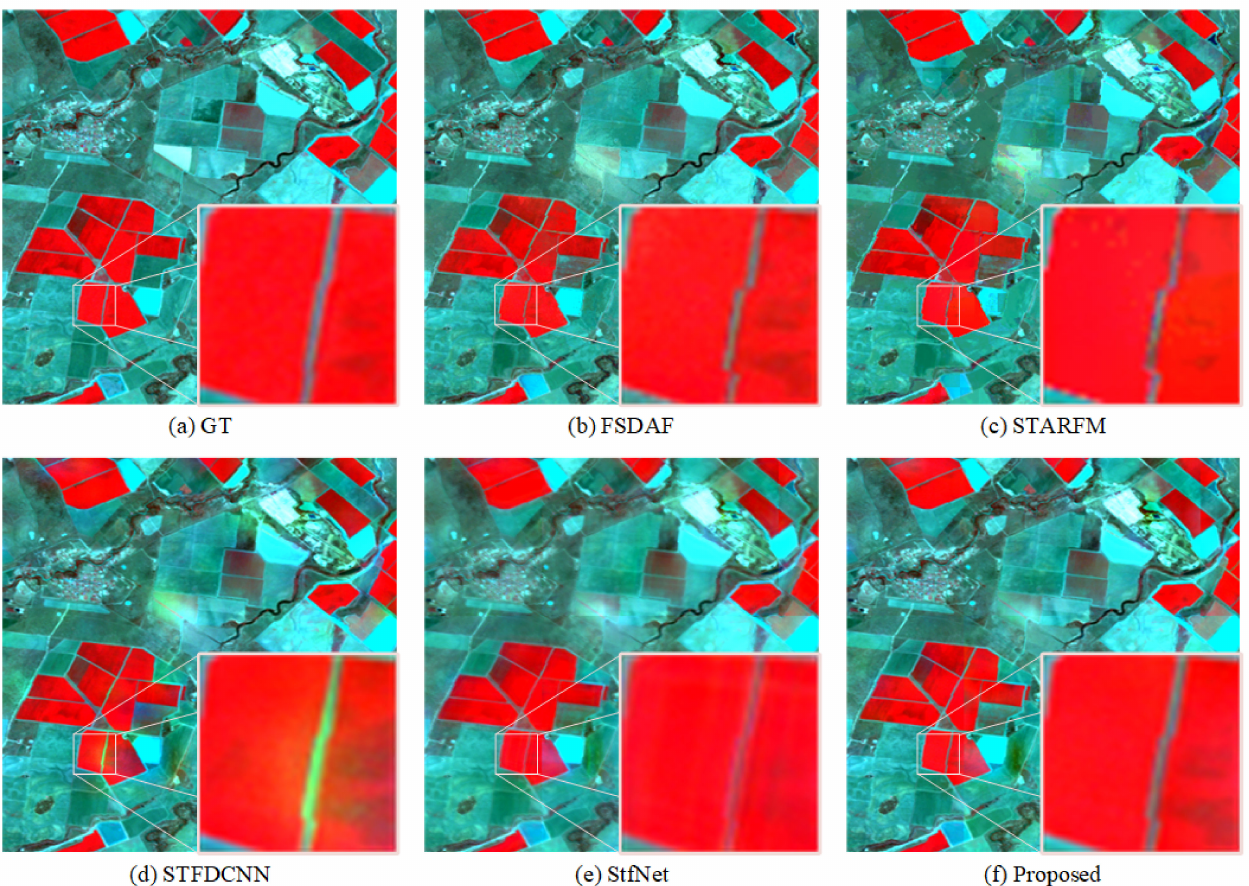
Figure 8. Prediction results for the target Landsat image (14 February 2005) in the LGC [31] dataset. Additionally, comparison methods include FSDAF [13], STARFM [8], STFDCNN [18], and StfNet [19], which are represented by ( b – e ) in the figure respectively. In addition, ( a ) represents the ground truth (GT) we got, and ( f ) represents the method we